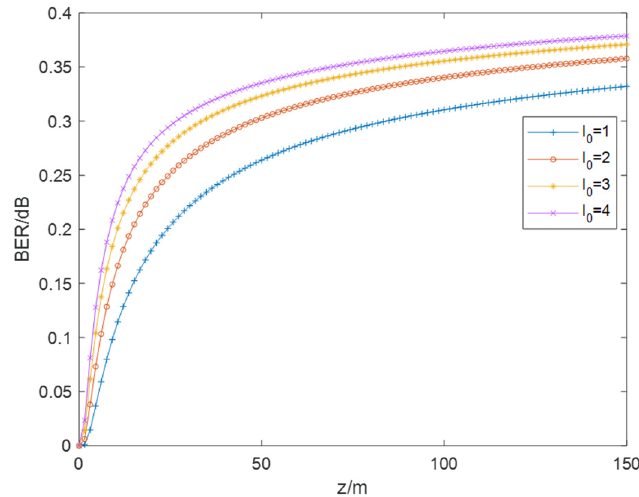
Figure 2. BER of the coaxial double-position power Gaussian vortex carrier communication link versus dissipation rate of the mean-squared temperature χ T for different topological charge of vortex.